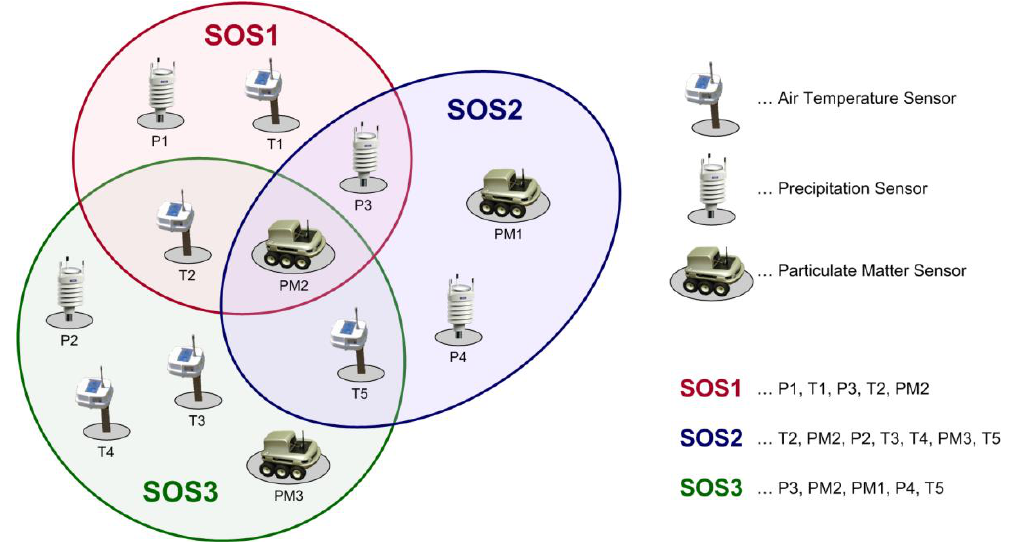
Figure 2. General SOS Usage Concept (Adapted from